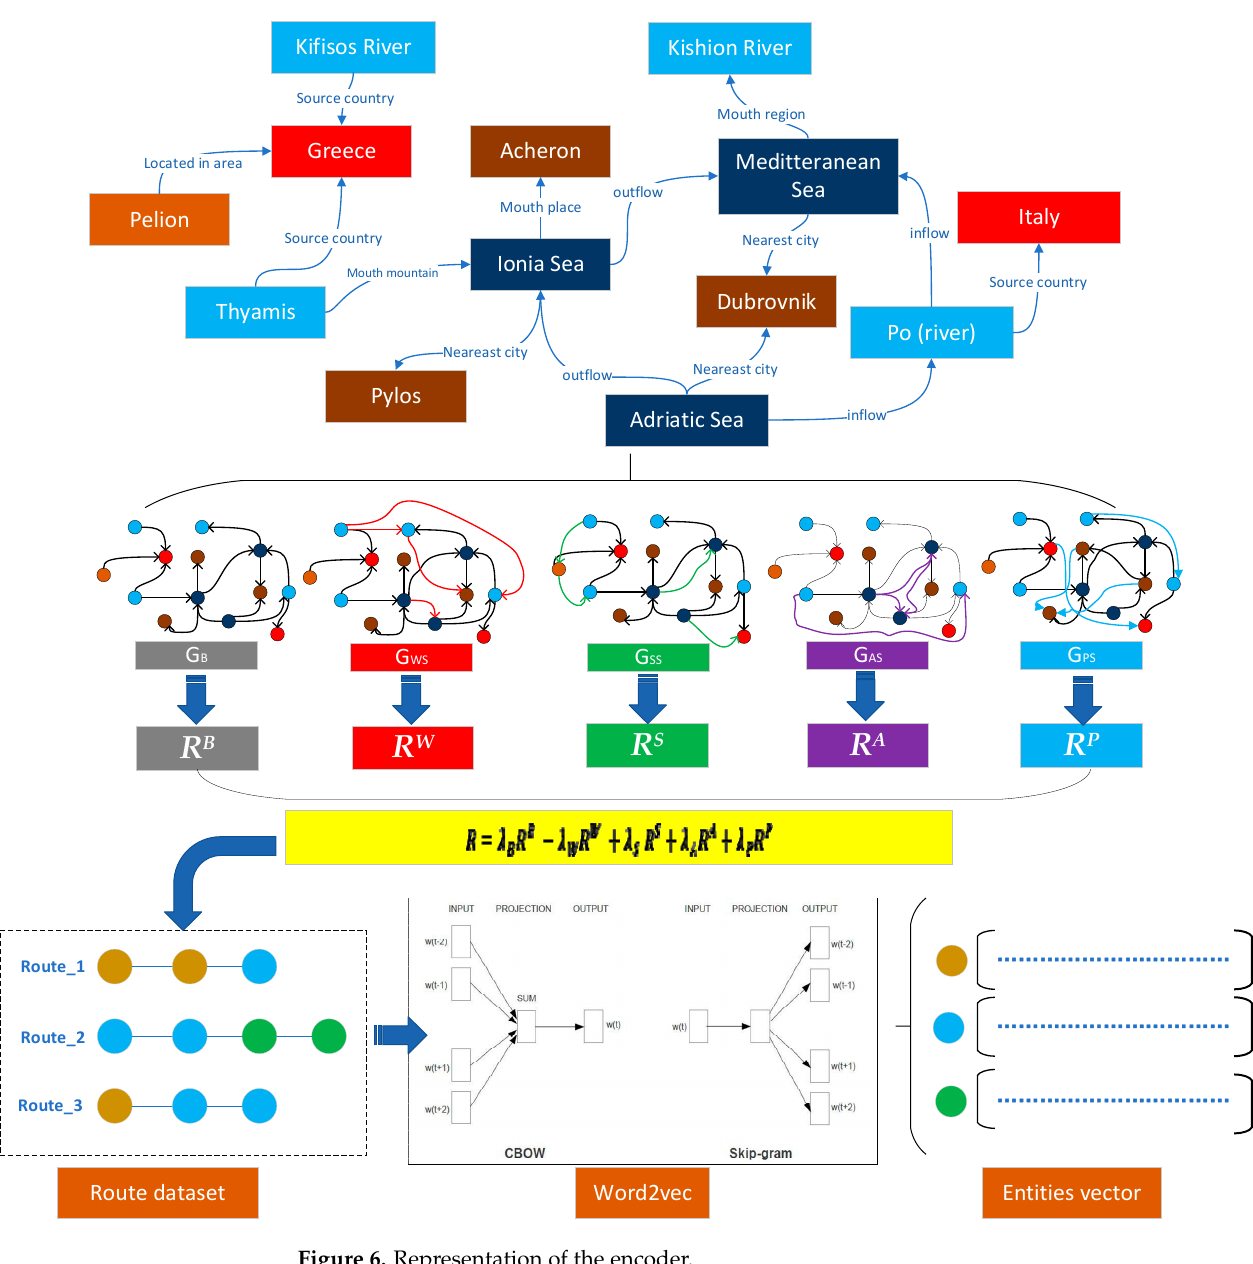
Figure 6. Representation of the encoder.